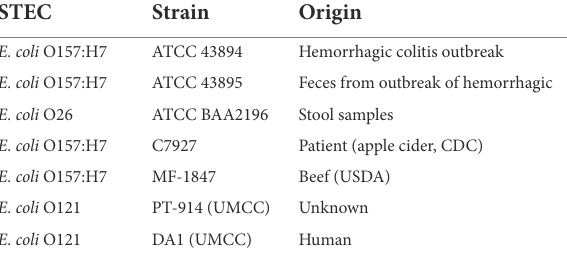
TABLE 1 Shiga toxin producing E. coli strains used in this